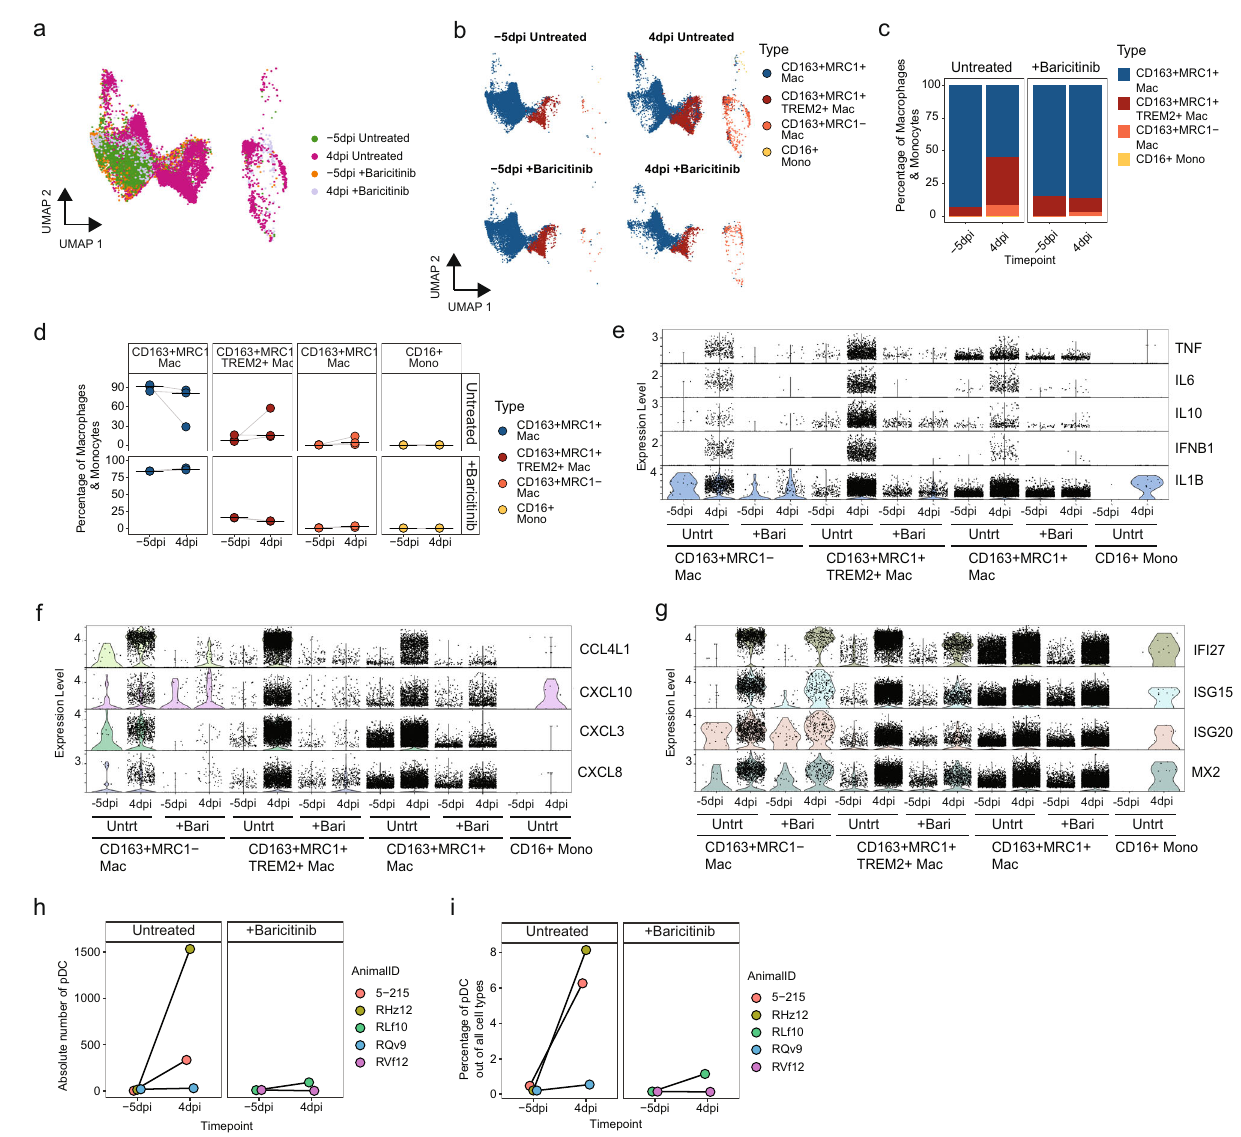
Fig. 5 | Baricitinib reduced the in fl ux of pro-in fl ammatory macrophages in addition to the pro-in fl ammatory gene expression pro fi le. a Projection of macrophages/monocytes from − 5dpi and 4dpi 10X BAL samples from three untreated and two baricitinib-treated rhesus macaques on the reference UMAP of uninfectedlungmacrophages/monocytes(NCBIGEO:GSE149758). b UMAPsplitby treatment and timepoint showing predictedcellannotations basedon mapping to the reference lung macrophages/monocytes. Percentage of a given macrophage/